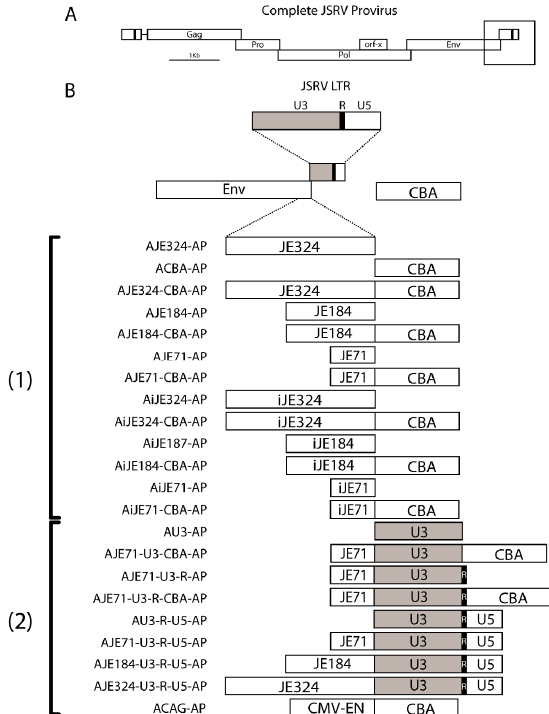
Figure 1. Schematic Diagram of Promoter / Enhancer Constructs. ( A ) The structure of an integrated Jaagsiekte sheep retrovirus (JSRV) provirus. A box is drawn around the 3 (cid:48) end of the env gene and the 3 (cid:48) long terminal repeat (LTR) where the putative enhancer lies. ( B ) Promoter / enhancer constructs used to drive human placental alkaline phosphatase reporter gene expression and determine if JE functions as a transcriptional enhancer. JE71, JE184, and JE324 refer to three di ff erent lengths of the putative JE enhancer region, 71, 184 and 324 bp in length, respectively. The JE sequences are taken from the 3 (cid:48) end of the env gene just prior to the start of the 3 (cid:48) LTR. In some constructs, the JE was inverted, denoted with an “i”. JE and inverted JE were placed in front of the chicken beta actin (CBA) promoter to determine if they could function upon a heterologous promoter. (2) A number of constructs were also evaluated for their utility as gene expression vectors. Constructs bearing the U3 region of the JSRV LTR, the U3 and R region of the LTR, or the full length JSRV LTR (U3, R and U5 regions),